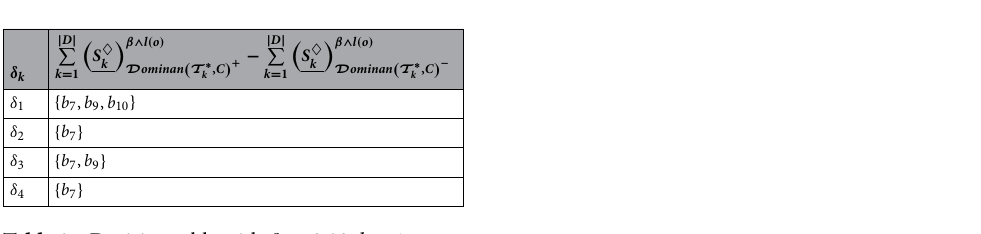
Table 9. Decision table with β = 0.90, l = 1 .